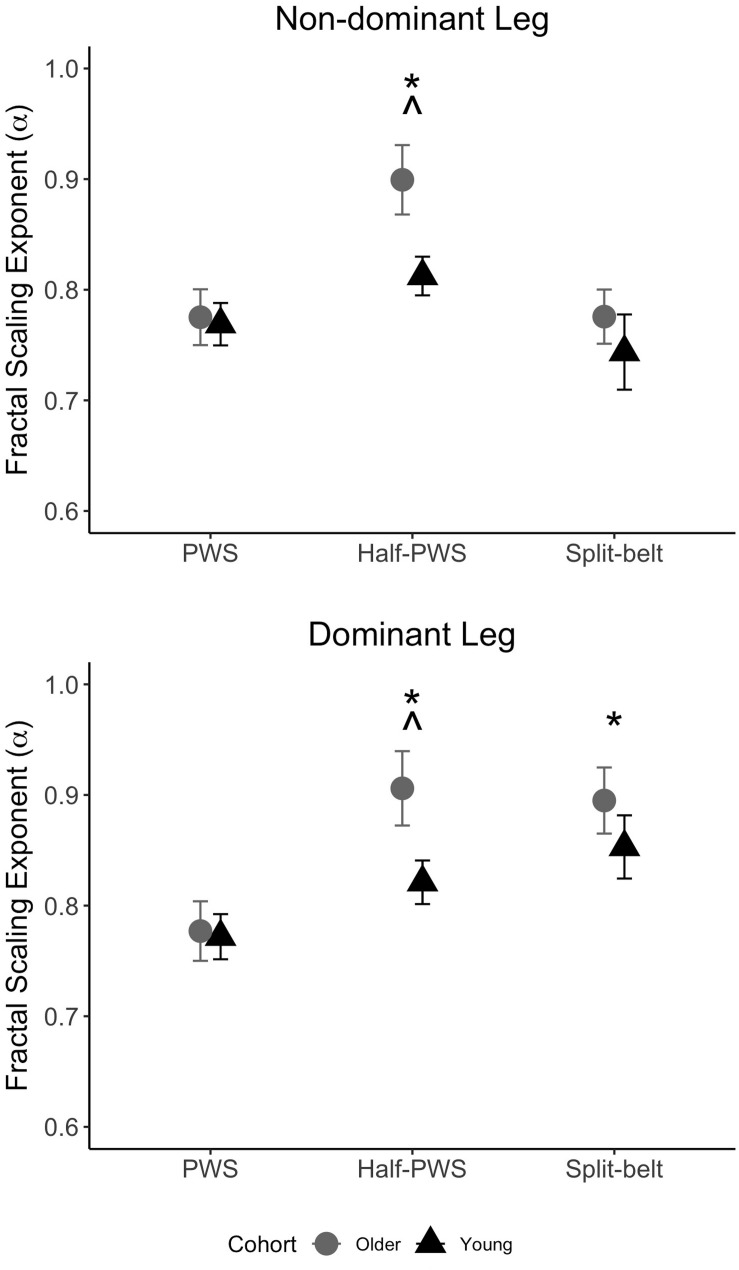
Fractal scaling across conditions for the non-dominant (top) and dominant (bottom) limbs in young (black triangles) and older (gray circles) adults. Data are mean ± SEM. P < 0.05: ∗ indicates > PWS; ∧ indicates condition (PWS, half-PWS) by cohort interaction.